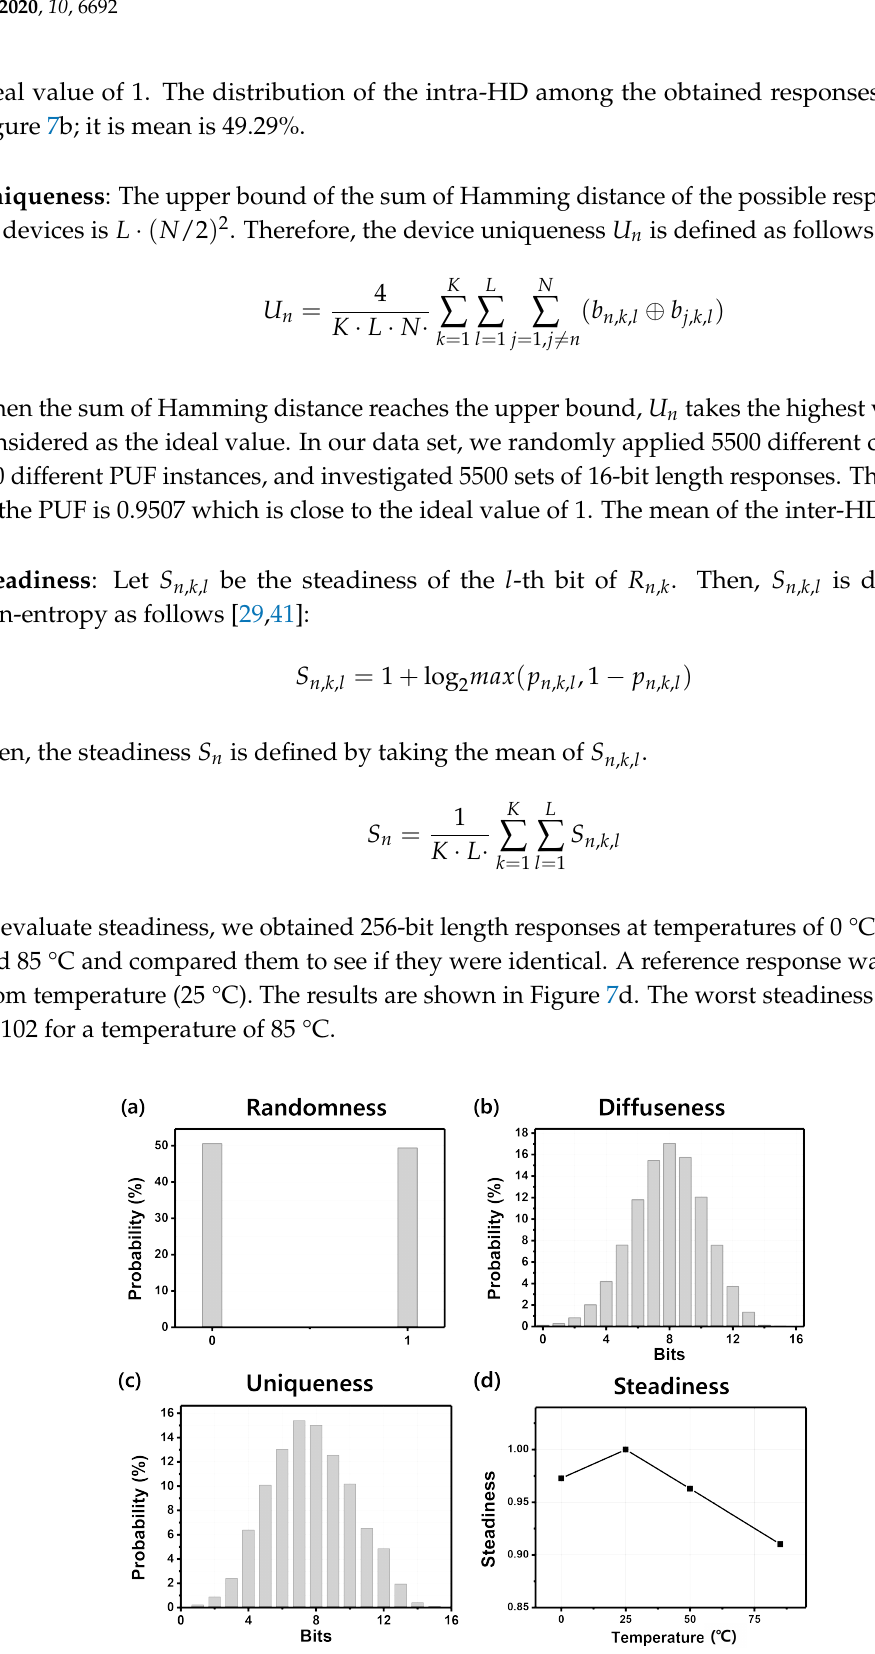
Figure 7. pm-PUF performance evaluation [29]: ( a ) randomness: occurrence probability of a 0 and 1 in the responses, ( b ) diffuseness: possibility of generating different responses with the same challenge, ( c ) uniqueness: possibility of generating different responses among different PUFs, and ( d ) steadiness under temperature variations (0 °C, 25 °C, 50 °C and 85